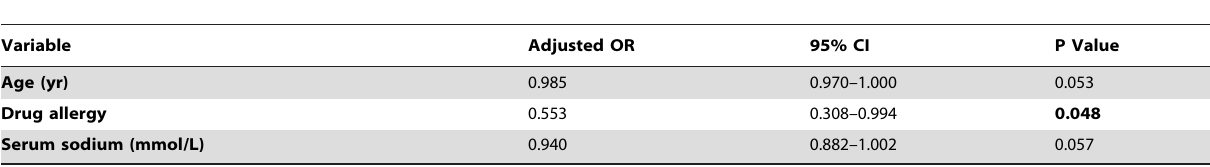
Table 3. Multivariate analysis for drug allergy and the risk of lymph node metastasis*.